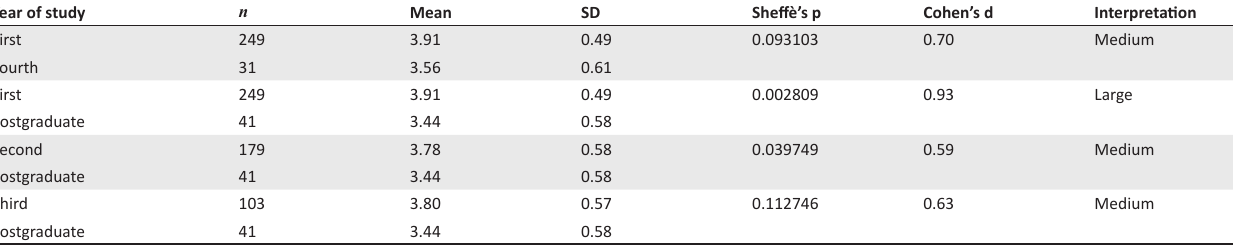
TABLE 7: The practical significance of the impact of year of study on organisational identification. Year of